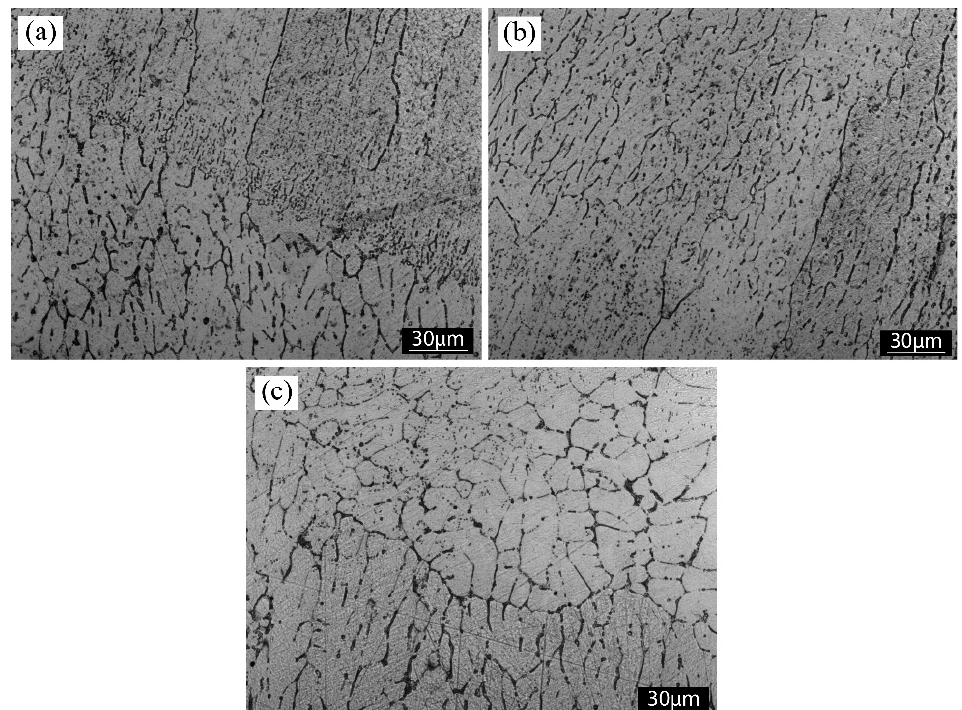
Figure 3. Microstructure of the typical ( a ) fusion line between the layers, ( b ) columnar grains observed along the entire structure, and ( c ) equiaxed grains visible on the top.